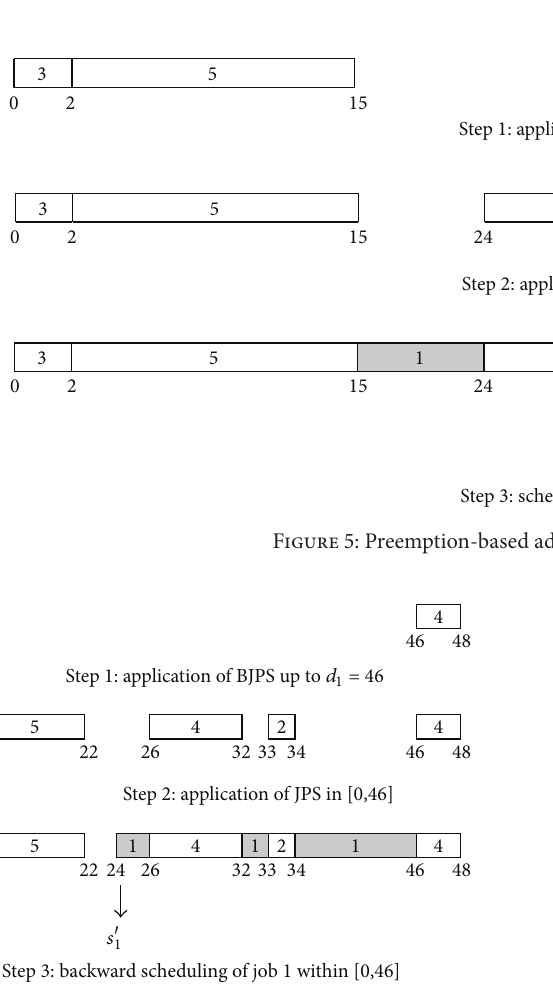
Figure 6: Preemption-based adjustment of 𝑑 1 (Example 1).